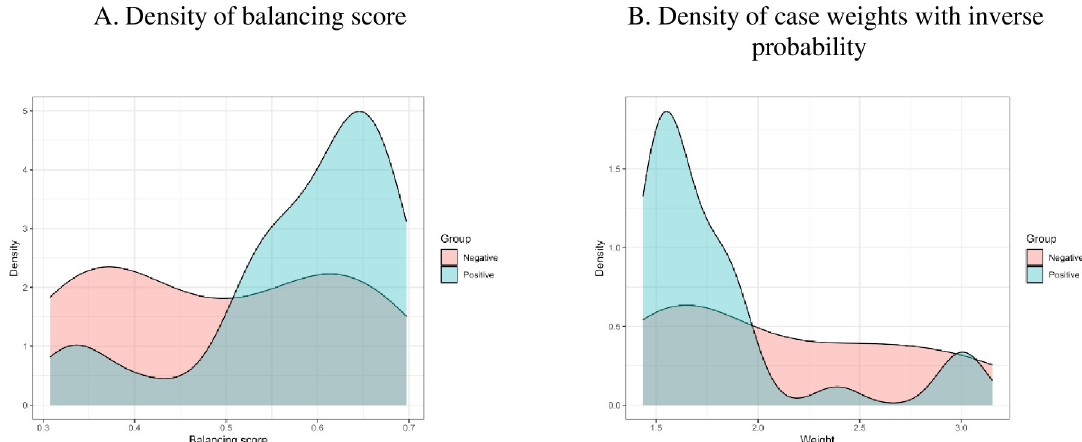
Fig 5. Distributions of the balancing score and case